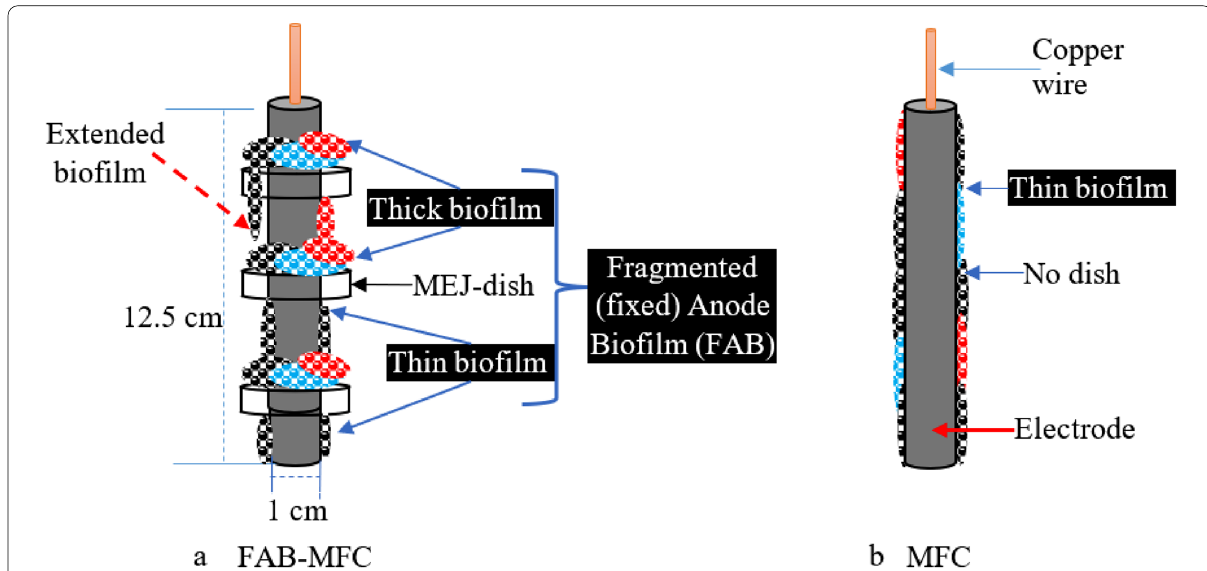
Fig. 3 Conceptual scheme of electro-active biofilm (EABs) formation on a microbial electrode jacket-dish (MEJ-dish) in fragmented electro-active biofilm-microbial fuel cell (FAB-MFC) anode, and b without MEJ-dish in MFC anode